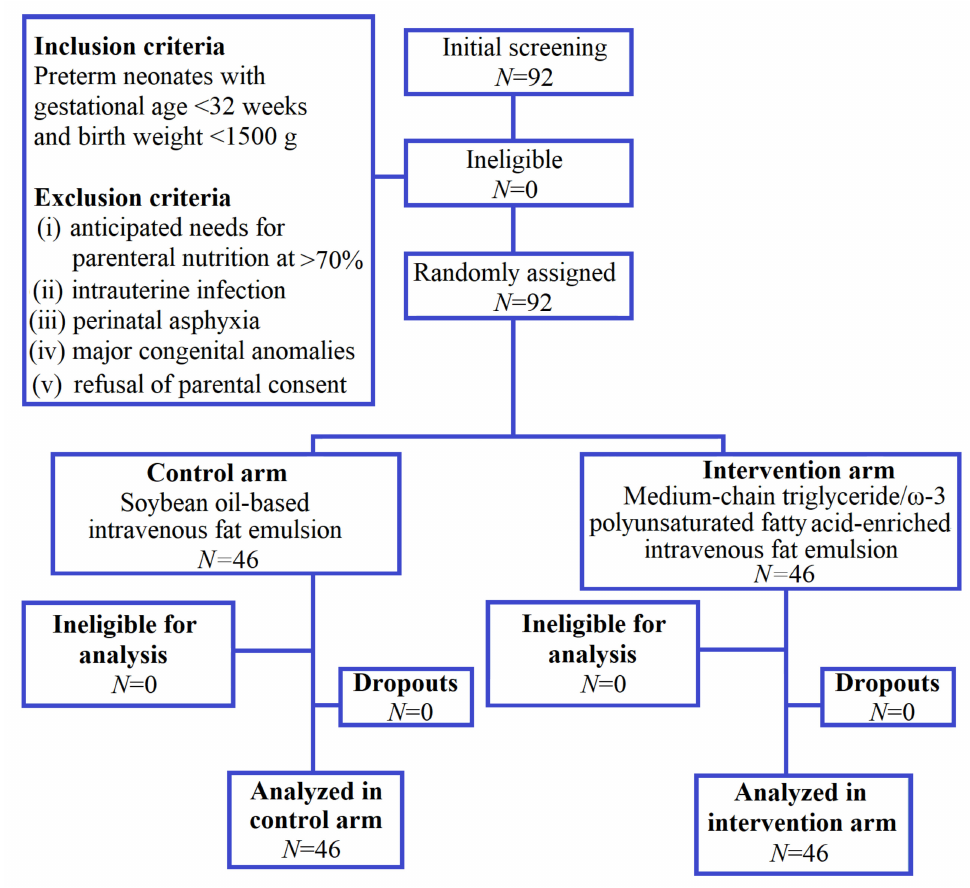
Figure 1. Study’s